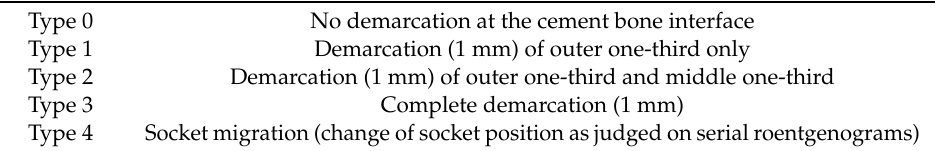
Table 2. Hodgkinson’s classification of Roentgenographic Demarcation of the socket.